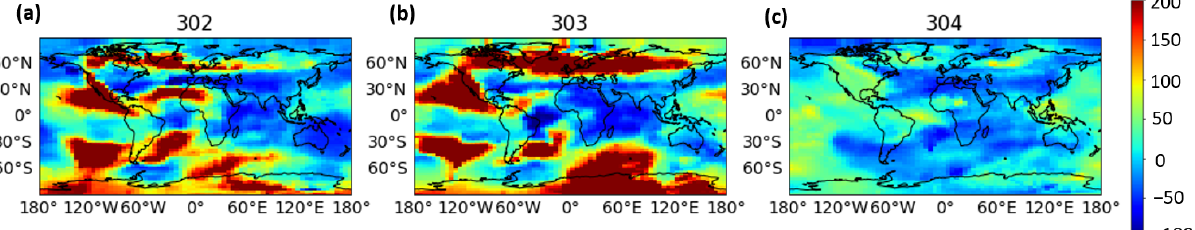
Figure 1. The relative total electron content (TEC) with respect to the preceding 27-day median (calculated according to Equation (1)) for the Halloween storms that occurred on 29 and 30 October 2003. The relative TEC is calculated using the UQRG global ionosphere maps (GIMs) from the Universitat Politècnica de Catalunya (UPC) analysis center. The main phase of the storms was on 29 and 30 October, which are day of year (DOY) 302 and 303, respectively. The recovery phase lasted several days, until 3–4 November 2003. The relative TEC percentages are plotted at 22 universal time (UT) for 29–31 October, which corresponds to DOY 302 ( a ), 303 ( b ) and 304 ( c ), respectively. There are neural-network (NN)-based approaches that also investigate the perfor- with data from a Peninsular Malaysia station from the years 2011 to 2014, was used by